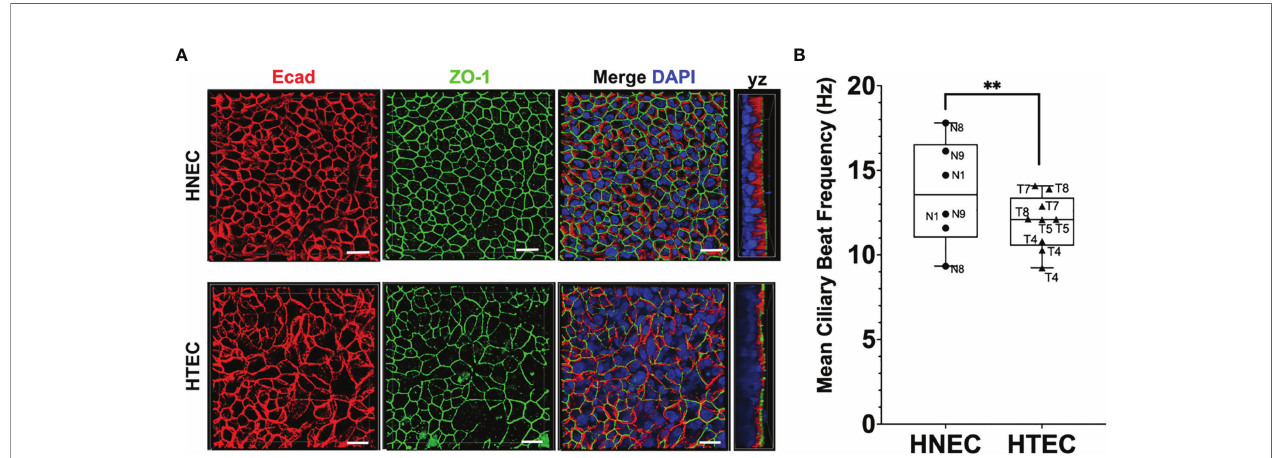
FIGURE 1 | Characterization of ciliated airway tissue models. (A) Whole mount immuno fl uorescent staining of E-cadherin (Ecad) and zonula occludens protein 1 (ZO-1) shows the typical honeycomb organization in both nasal (HNEC) and tracheo-bronchial (HTEC) tissue models cultured at the air-liquid interface for 21 days. Scale bars: 20 µm. (B) The mean ciliary beat frequency (CBF) of nasal tissue models was signi fi cantly higher compared to tracheo-bronchial models (unpaired t-test, **p ≤ 0.01). Boxplots show means and standard deviations (error bars) of the CBF of at least 30 ciliated cells per tissue model (HNEC-based models: N=3, HTEC- based models: N=4). The graphs also show individual data points to analyze inter- and intra-donor